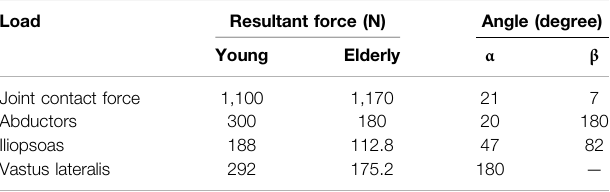
TABLE 3 | Muscle and joint contact forces in the proximal femur models for the young and the elderly (Simões et al., 2000; Doherty, 2001; Williams et al., 2002; Diffo Kaze et al., 2017; Sangeux, 2019). Load